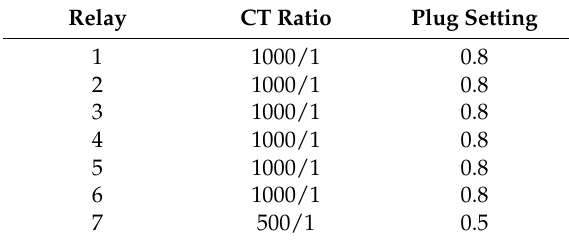
Figure 11. A single-end, multi-parallel feeder distribution system. Table 9. CT ratios and plug settings of the relays for Case